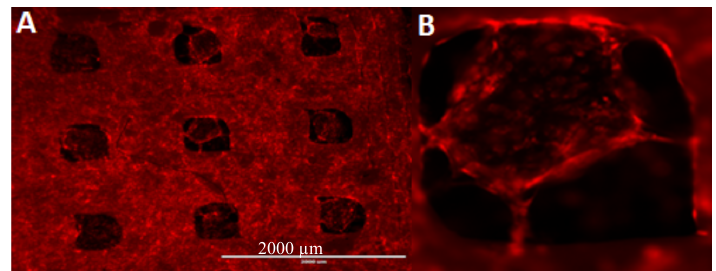
Figure 7. HUVECs seeded on PLA collagen–SDF-1 scaffolds. The cells adhere to the cage and seem to grow from the outside of the cage into the collagen gel ( A ). Thereby they start to form neo-vessel-like structures comparable to cells grown in Matrigel ( B ). Scale bar represents 2000 µm.